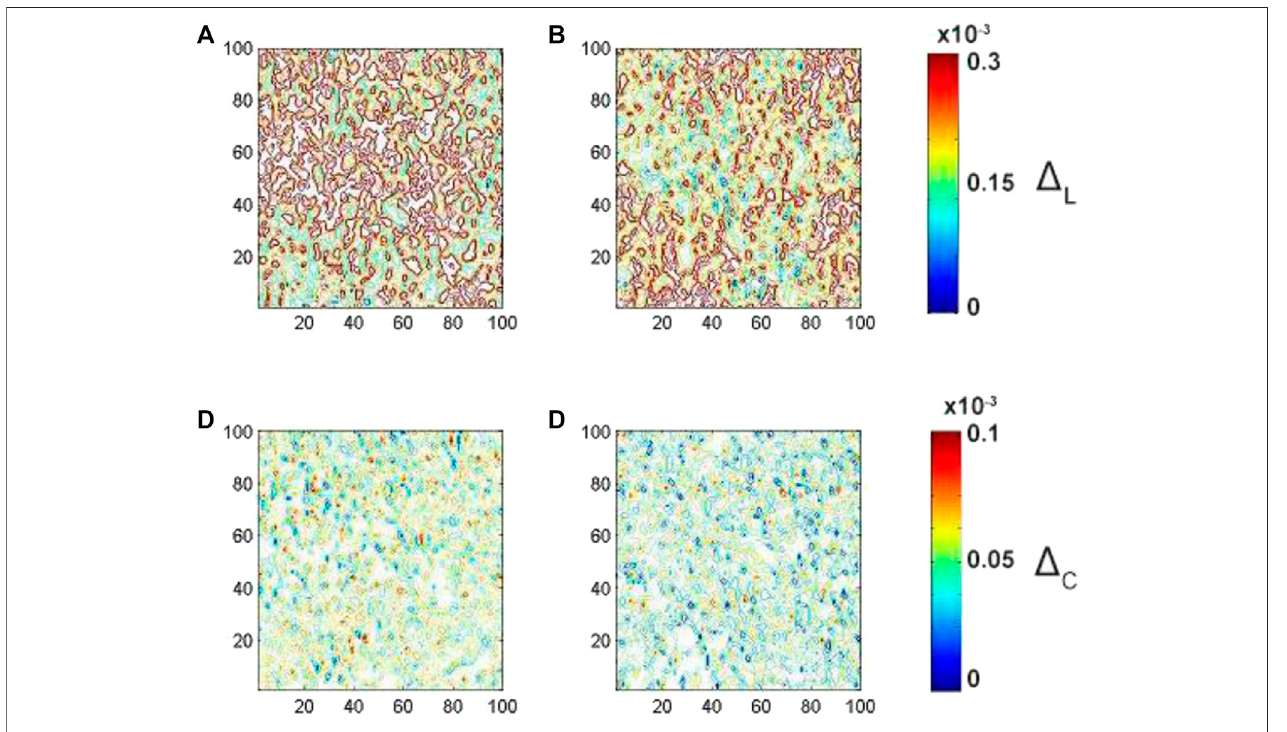
FIGURE 6 | Embossed topographic maps of (A) linear Δ L ( θ 3 (cid:1) 1 . 5 rad 5 z p 3 ≈ 100 μ m ) and (B) Δ L ( θ 4 (cid:1) 2 . 3 rad 5 z p 4 ≈ 150 μ m ) birefringence and circular (C)